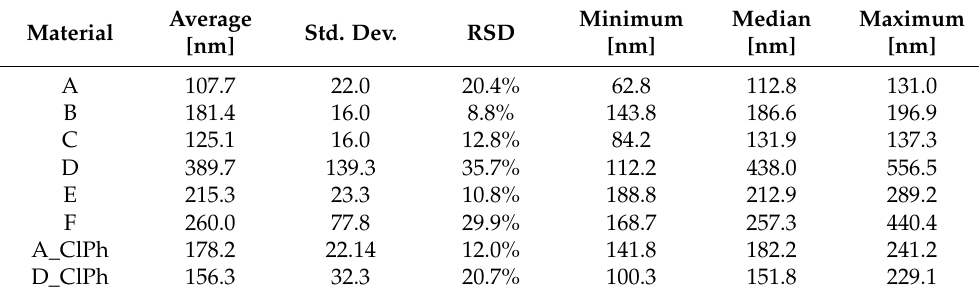
Table 3. Statistical summary of the particle size measurements (nm) for silica nanoparticles obtained using the dynamic light scattering (DLS)